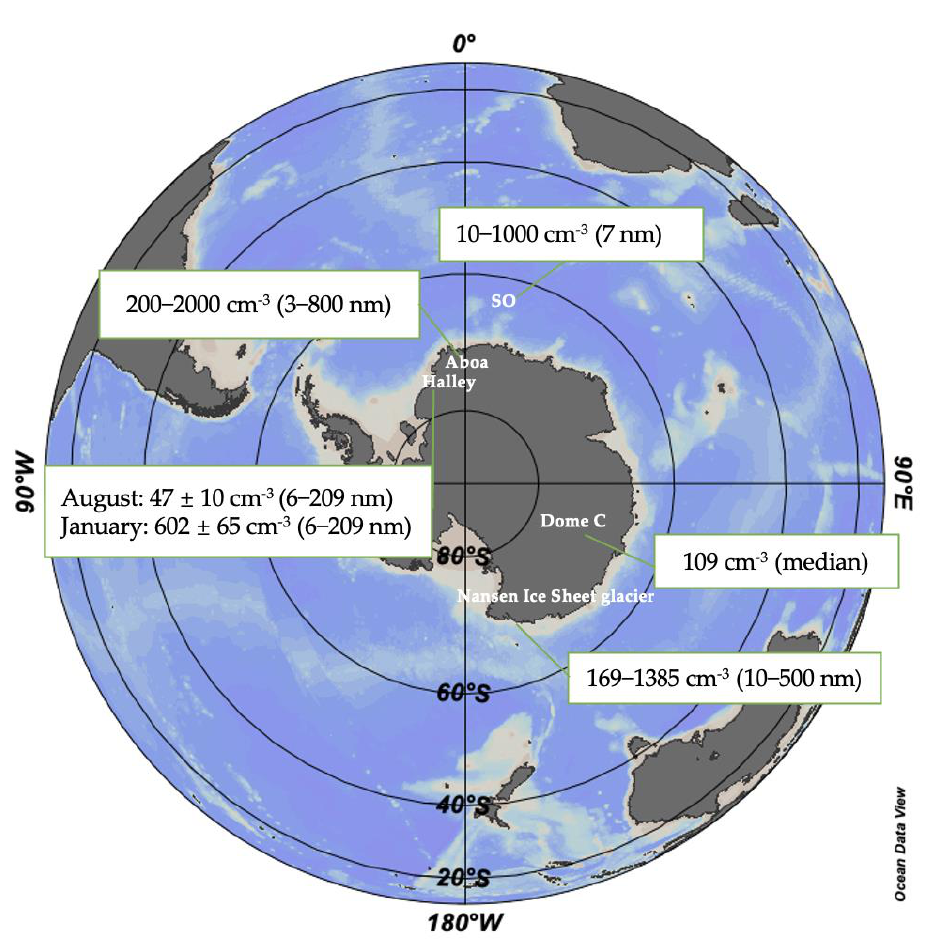
Figure 1. Total aerosol number concentrations over the SO and Antarctica.